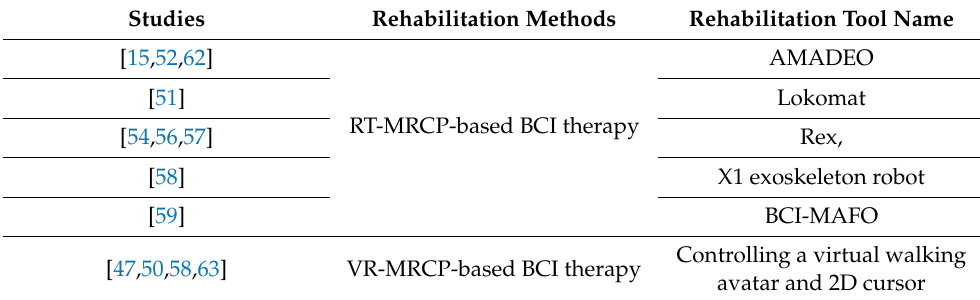
Table 2. Applied rehabilitation methods in identified